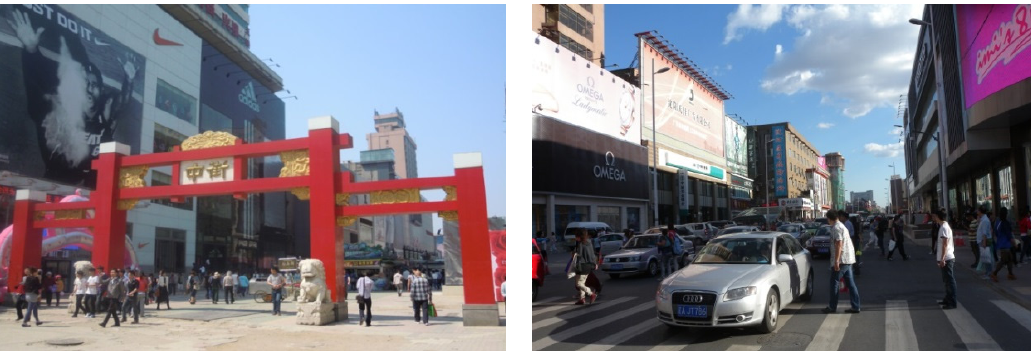
Figure 2. Streetscape in Zhongjie,